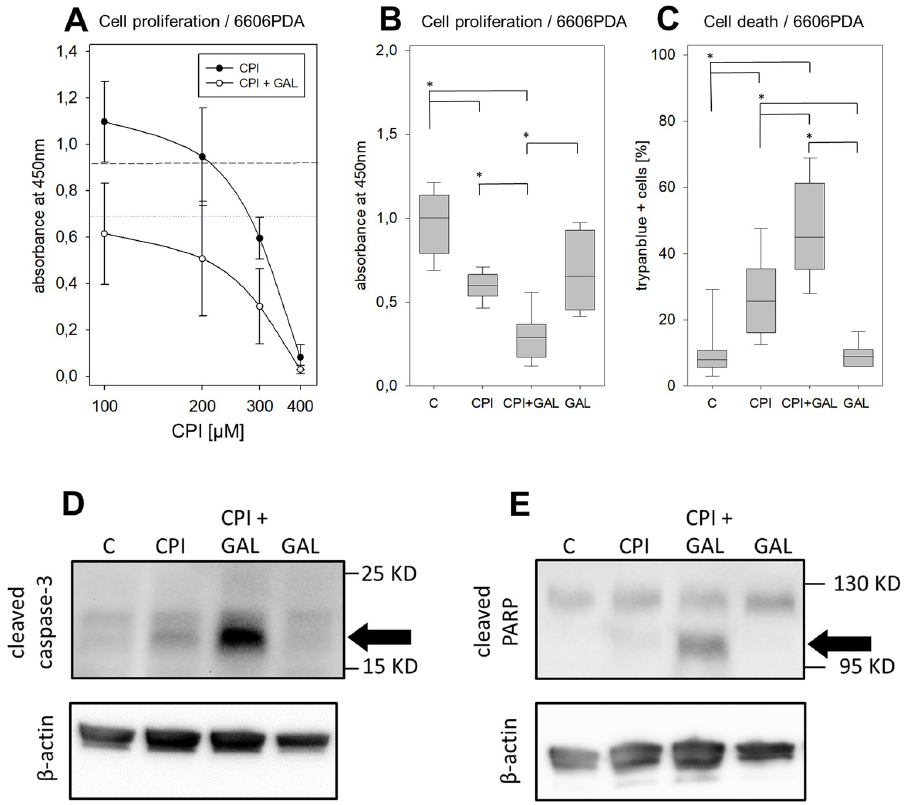
Fig 2. CPI-613 in combination with galloflavin inhibits pancreatic cancer cell proliferation and induces cell death. ( A ) Proliferation of 6606PDA cells after cultivating them in CPI-613 (100–400 μ M) with and without 30 μ M galloflavin (GAL; dotted lines indicate mean value of absorbance for control treated cells, either with high or low DMSO concentrations). ( B ) Analysis of proliferation by BrdU-ELISA, ( C ) or quantification of cell death by trypan blue assay, after cultivating 6606PDA cells 24 h in control medium with the respective amount of the vehicle DMSO (C), medium supplemented with 300 μ M CPI-613 (CPI), 30 μ M galloflavin (GAL) or the combination of both drugs (CPI + GAL). ( D-E ) Apoptosis was assessed by analyzing the cleavage of caspase 3 (caspase-3) and PARP via western blot, after treating the cells with medium supplemented with DMSO (C), 300 μ M CPI-613, 30 μ M galloflavin or the combination for 24 h respectively (the bands of the cleaved proteins are indicated by black arrows). Statistics were performed with ANOVA on Ranks Holm-Sidak method for multi comparison, significant differences: � p � 0.004; Independent experiments: A-B: n = 8–10, C: n = 19, D-E: n = 2–3.